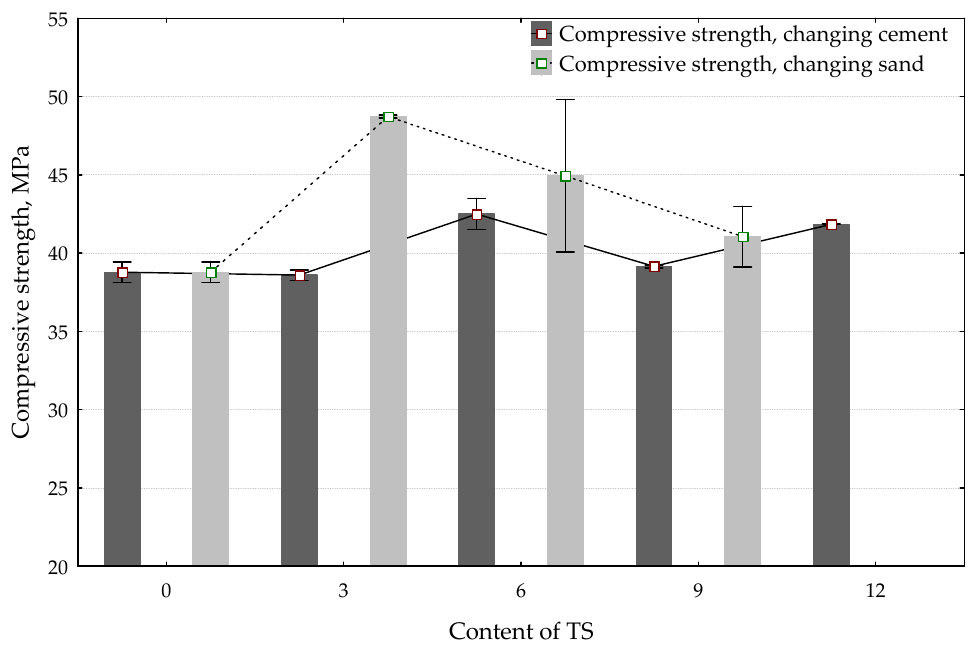
Figure 7. The e ff ect of TS content in the mix on compressive